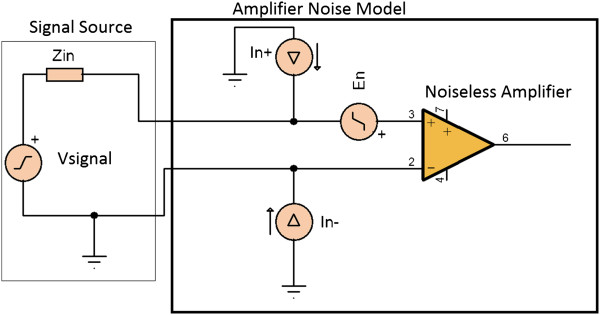
Amplifier noise model.